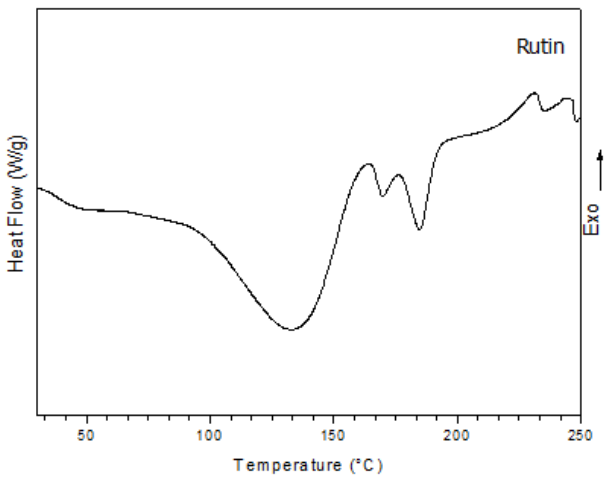
Figure 2. Di ff erential Scanning Calorimetry (DSC) curve of RUT under N 2 Figure 2. Differential Scanning Calorimetry (DSC) curve of RUT under N 2 atmosphere.